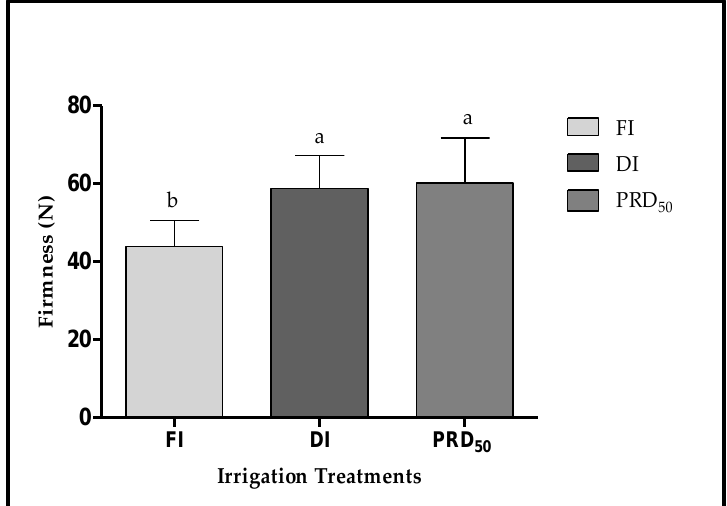
Figure 5. Fruit firmness ( ± SD) of Flordastar peaches grown under FI, DI and PRD 50 irrigation treatments, expressed in (N). Different letters refer to significant differences tested by Duncan’s multiple range test ( p < 0.05).